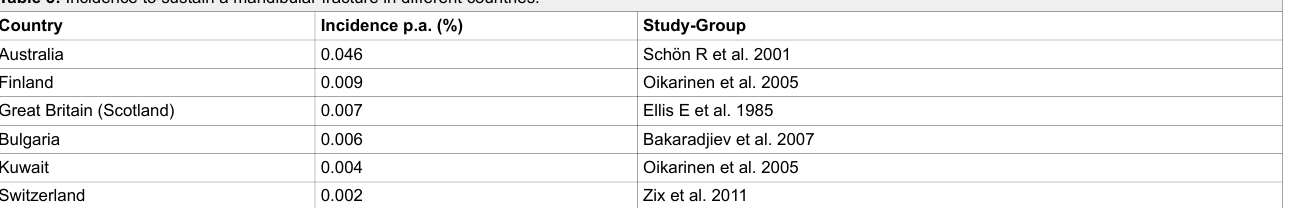
Table 3: Incidence to sustain a mandibular fracture in different countries. Country Incidence p.a.